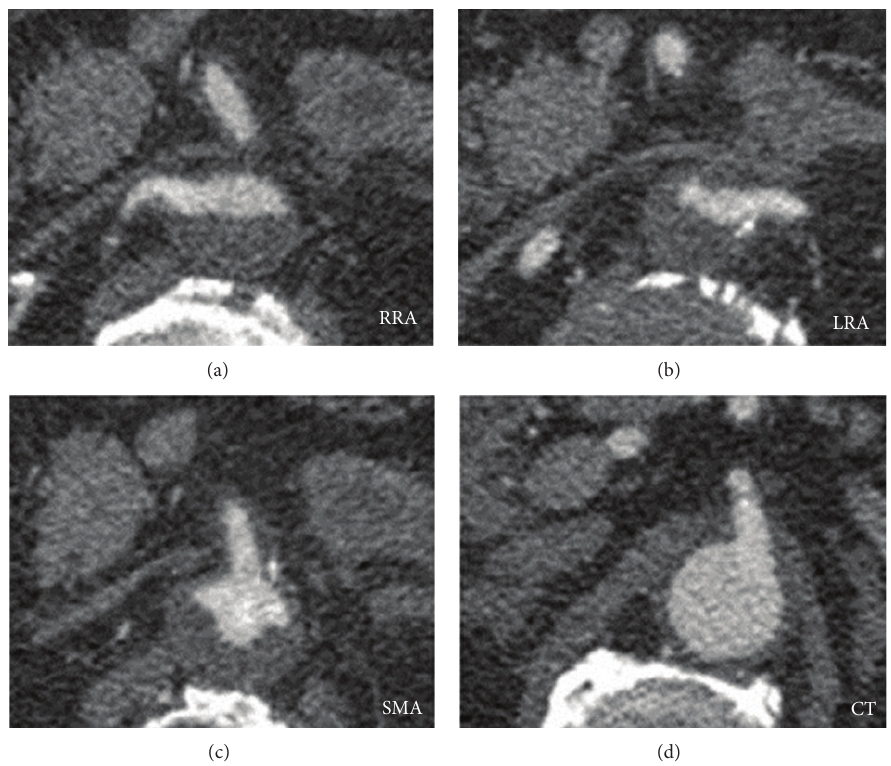
Figure 2: Axial view of the almost complete retrograde thrombosis to the level of the renal arteries and superior mesenteric artery (RRA: right renal artery; LRA: left renal artery; SMA: superior mesenteric artery; CT: celiac